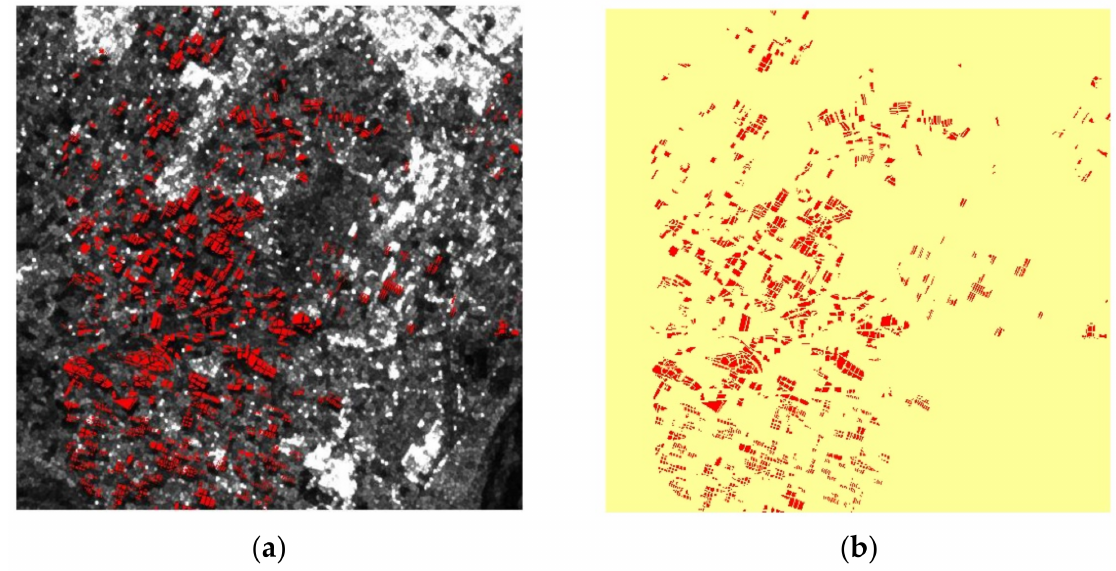
Figure 13. The selected area of Hualien County of ( a ) Sentinel-1 image with ground truth and ( b ) rice detection result. Rice is shown in red and non-rice in